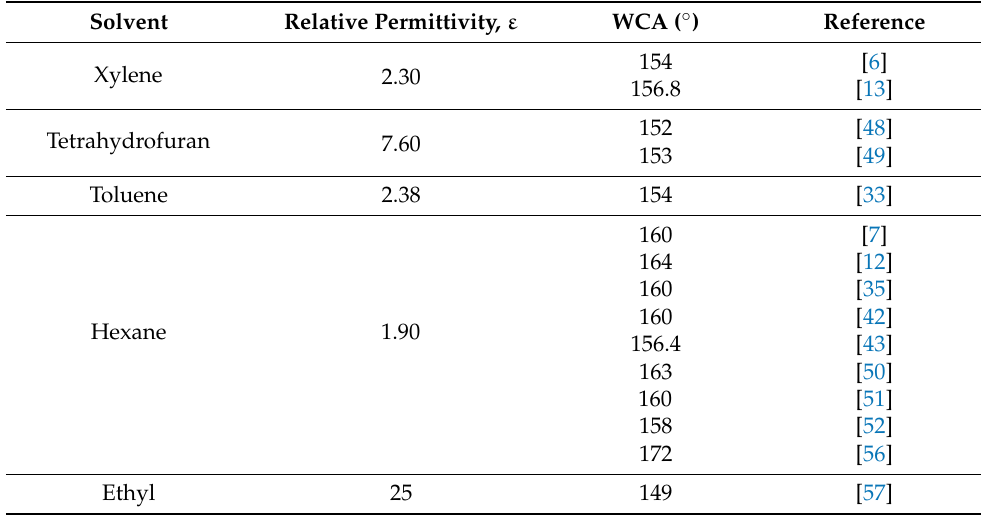
Table 2. Various solvents with respective relative permittivity and water contact angle. Solvent Relative Permittivity,